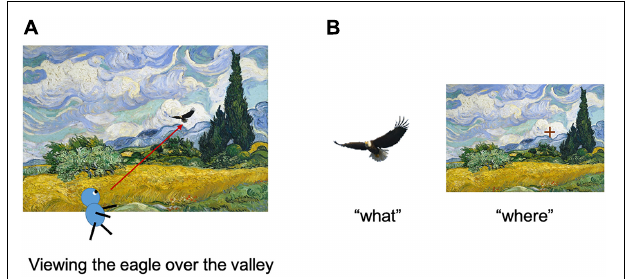
FIGURE 1 | Encoding of items and their location in a scene. (A) Assume that a subject is viewing the eagle in the wheat field. (B) The item information of the eagle (left) and its location in the environment (right) were acquired using this process. Adapted with permission from Chen and Naya